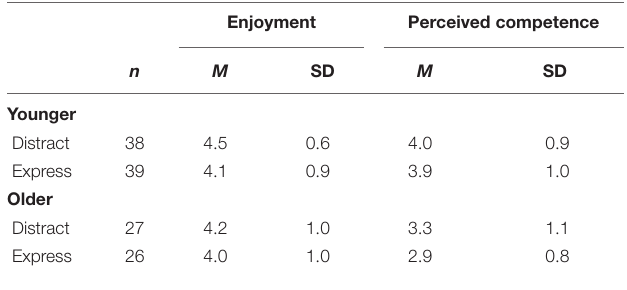
TABLE 2 | Means and standard deviations for enjoyment and perceived competence by condition and age